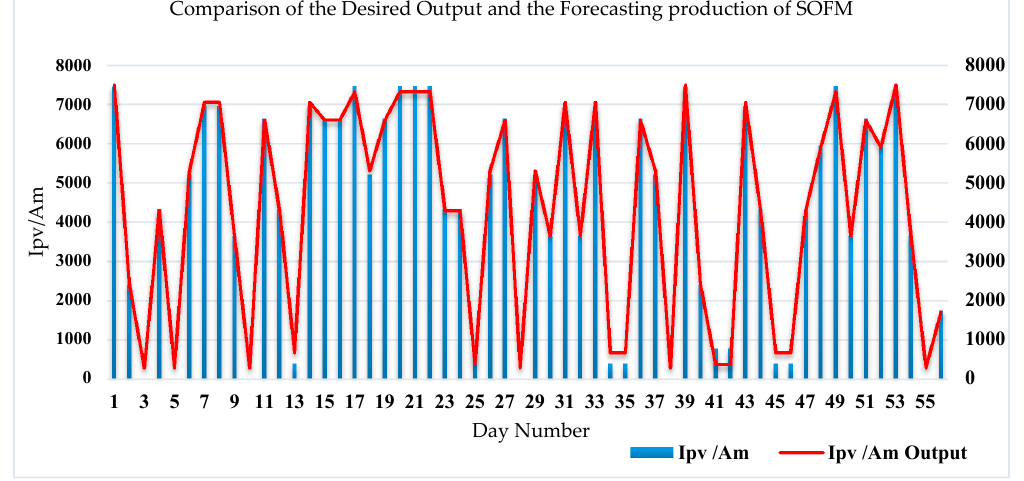
Figure 16. Comparison of the desired output and the forecasting production of SOFM.